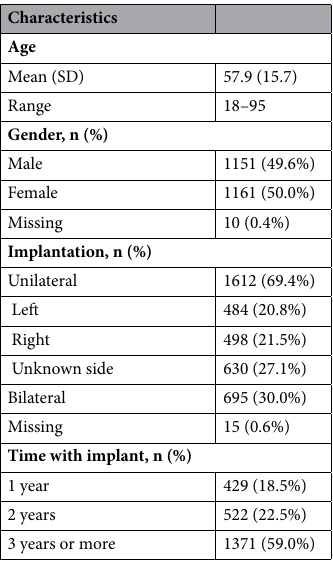
Table 1. Characteristics of study